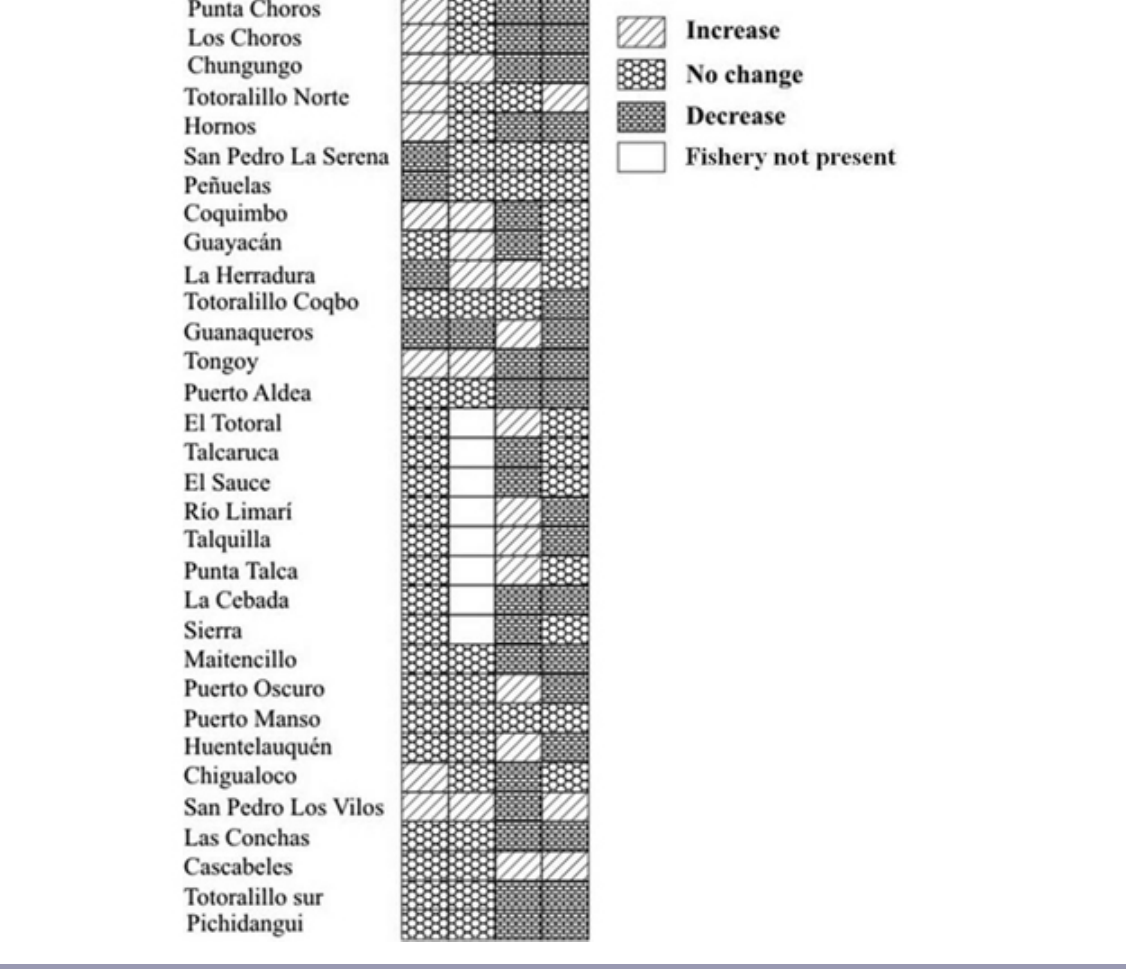
Fig. 6 . Changes of the per capita income produced by the different resources landed in each caleta. Resources: Fi, fishes; Sq, squid; Sw, seaweed; In, invertebrates. The general trend is identified based on the slope of the regression of income versus